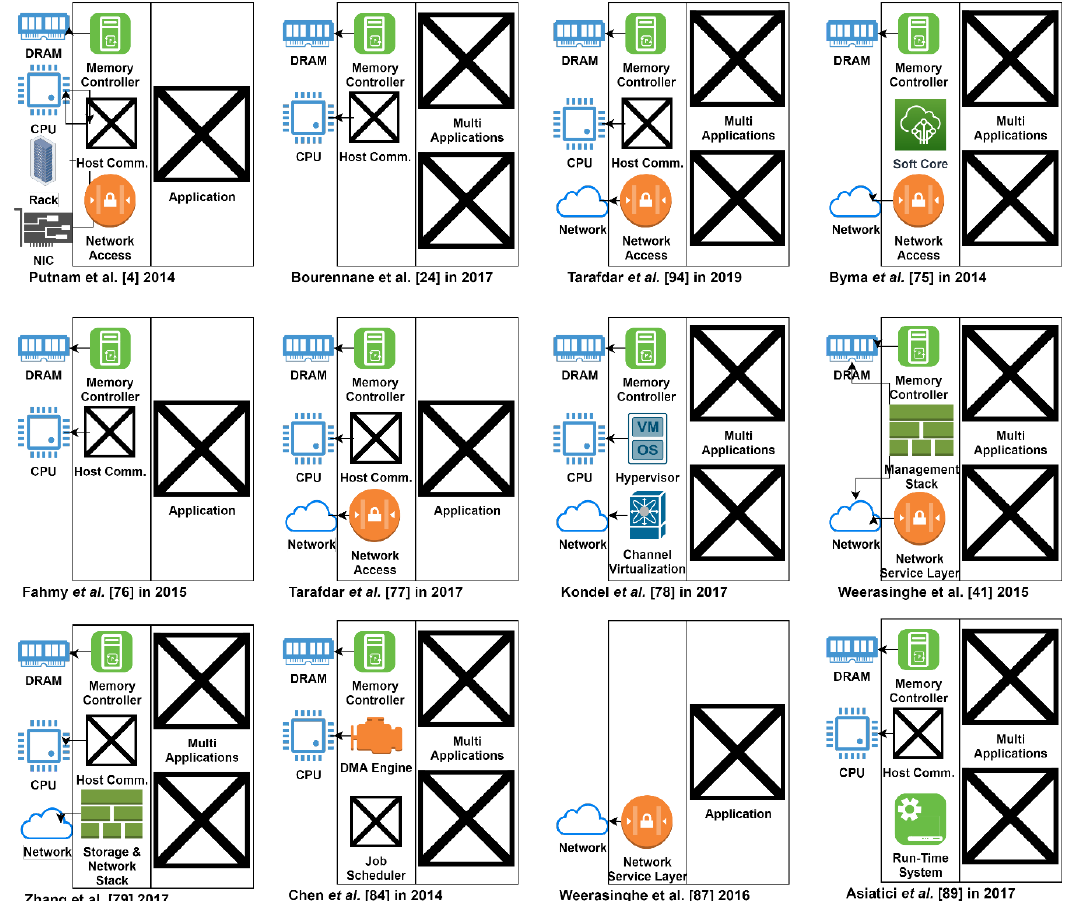
Figure 4. Possible Architectures for Utilization of FPGA(s) in Datacenter.